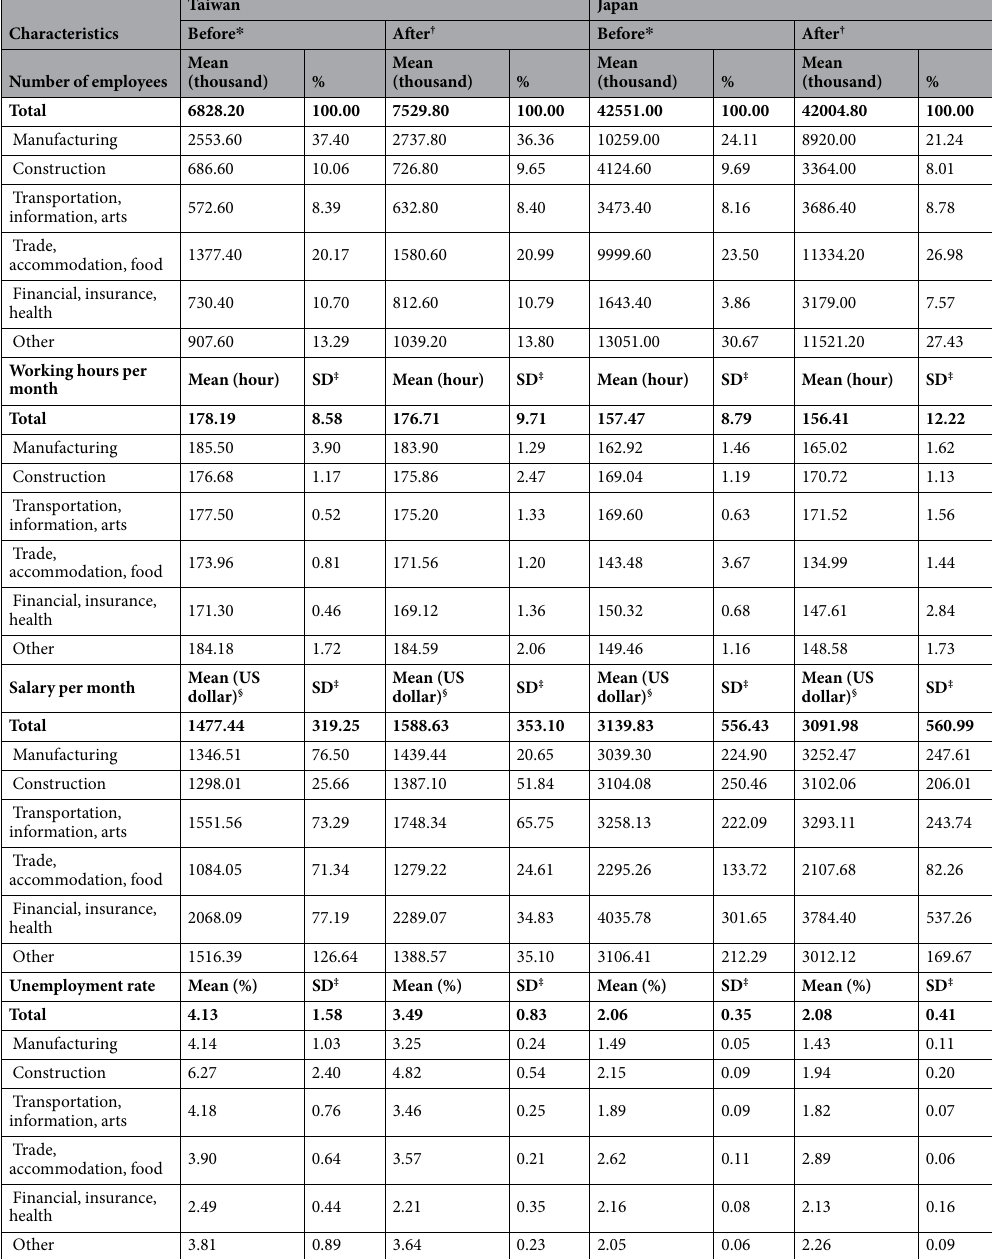
Table 3. Characteristics of the workforce and working conditions in Taiwan and Japan before and after implementation of new criteria for overwork-related cardiovascular and cerebrovascular diseases, by industry sector. * Defined as 5 years before the new criteria: 2006–2010 for Taiwan and 1997–2001 for Japan. † Defined as 5 years after new criteria: 2011–2015 for Taiwan and 2002–2006 for Japan. ‡ SD = standard deviation. § Based on average annual exchange rate and adjusted for Consumer Price Index 18–21